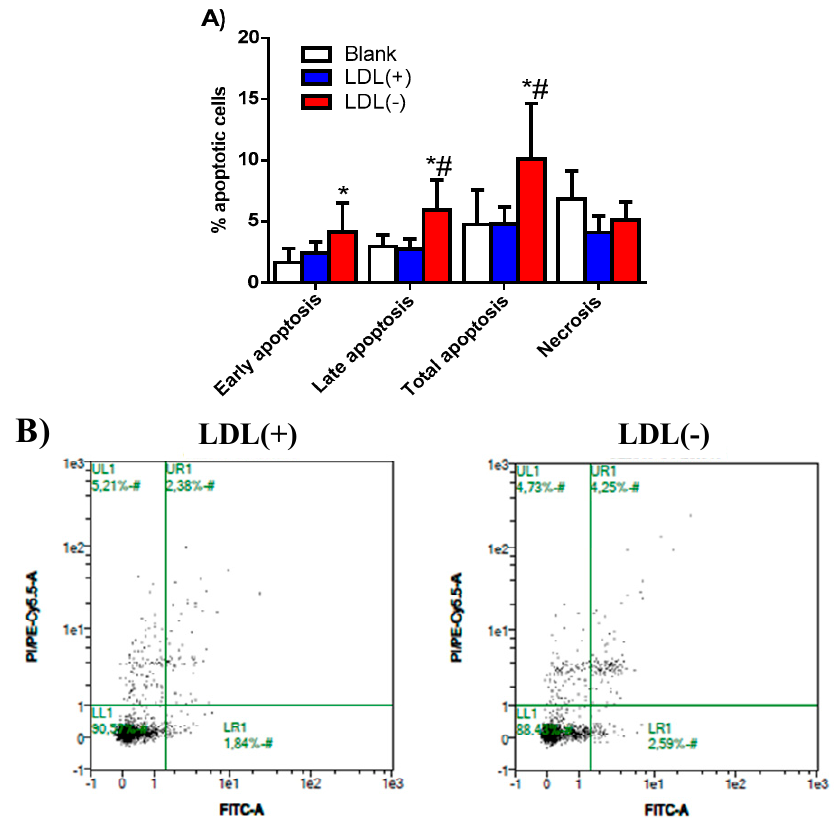
Figure 6. Apoptosis induced by LDL( + ) and LDL( − ) in human monocytes. ( A ) Early, late, and total apoptosis, and necrosis induced in basal conditions (blank) or by LDL( + ) (blue bars) and LDL( − ) (red bars) (60 mg apoB / L) were evaluated by flow cytometry. Results are expressed as percentage of apoptotic cells, mean ± SD ( n = 6), * vs. blank cells, and # vs. LDL( + ), p < 0.05 ( B ). Representative experiment showing the e ff ect of LDL( + ) (left panel) and LDL( − ) (right panel) on human monocytes. The e ff ect of enzyme inhibitors was also assayed in LDL( − )-induced apoptosis. Figure 7 shows that DMS enhanced the apoptotic e ff ect of LDL( − ), whereas CPZ decreased this e ff ect, both in early and late apoptosis. These observations suggest that Cer is involved in LDL( − )-induced apoptosis, whereas S1P would tend to counteract this action. On the other hand, the presence of MAPP did not promote any significant effect, despite a slight tendency to increase late apoptosis. Figure 7. Apoptosis induced by LDL( − ) in the presence of inhibitors. Early, late, and total apoptosis induced by LDL( − ) (60 mg apoB/L) were evaluated in the absence or presence of MAPP (yellow bars), DMS (green bars), or CPZ (purple bars), all at 10 µM. Results are expressed as fold change in apoptosis versus LDL( − ) in the absence of inhibitors, mean ± SD ( n = 6), * vs. non-inhibitor, p < 0.05. However, MAPP and CPZ alone did not promote apoptosis in the absence of LDL( − ), whereas DMS did (Supplementary Table S1). LDL(+) was modified to increase its content in Cer, Sph, and NEFA, in order to reproduce the apoptotic behavior of LDL( − ). Figure 8 shows that although NEFA-LDL and Sph-LDL promoted a slight non-significant apoptotic effect, the highest and statistically significant effect on total apoptosis was found when Cer content in LDL increased after SMase treatment.